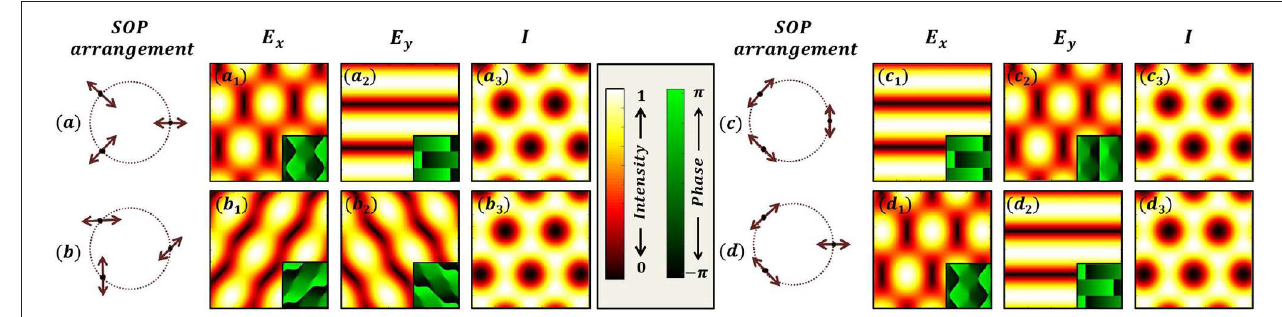
FIGURE 5 | Intensity degeneracy in the interference of three non-coplanar plane waves. The SOPs of the three plane waves in four different cases are presented in (a–d) . In each case, the SOPs of the three plane waves are segregated in x and y components and components wise interference patterns are analyzed. By adding the component wise intensity patterns, the total intensity pattern is obtained. Note that in each case the component wise interference patterns are different but at the end the total intensity remains the same. This means the spatial arrangement of polarization states leads to readjustment in their components without any change in